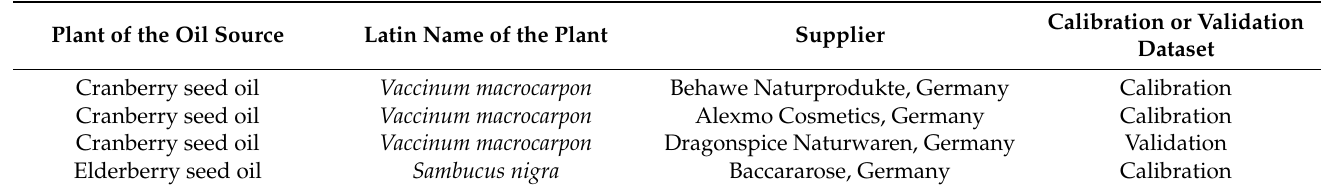
Table 5. Samples of vegetable oils used in the